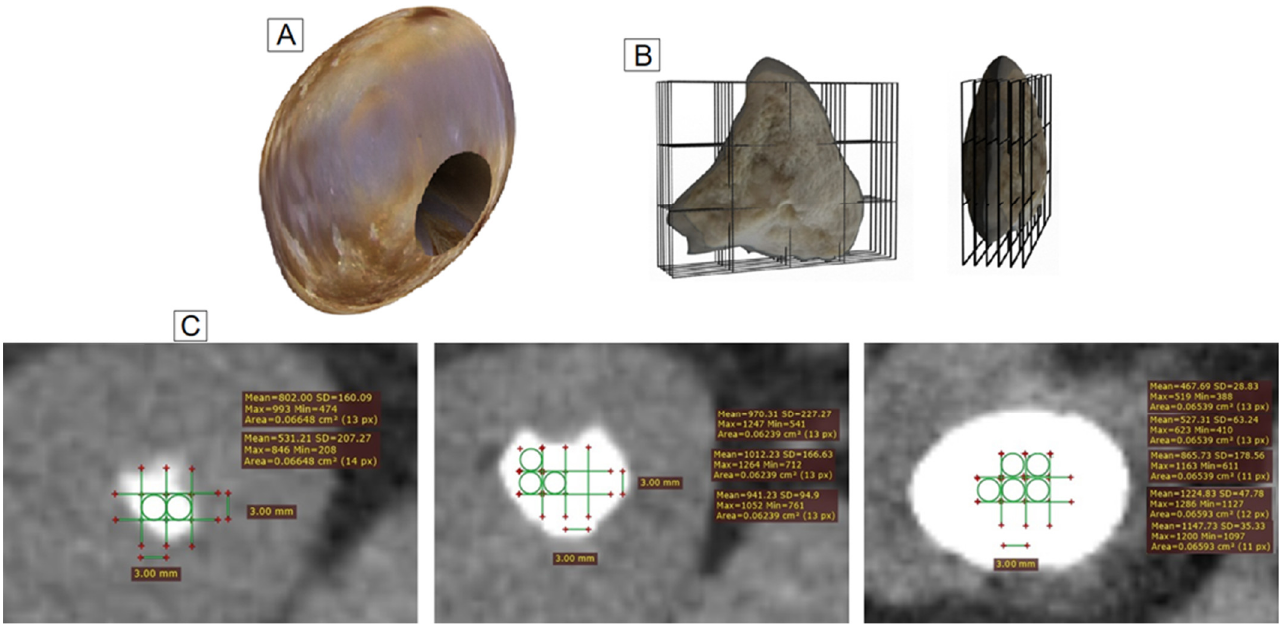
Figure 2. Representative diagram of the systematic method to obtain the HU in the samples. ( A ). Renal stone after percutaneous nephrolithotomy. ( B ). Sample (a small part of the stone) with the superimposed grid and moved in the axial plane (every 1.2 mm). ( C ). Tomographic images, with superimposed grids, of a cortex, middle and nucleus, respectively.